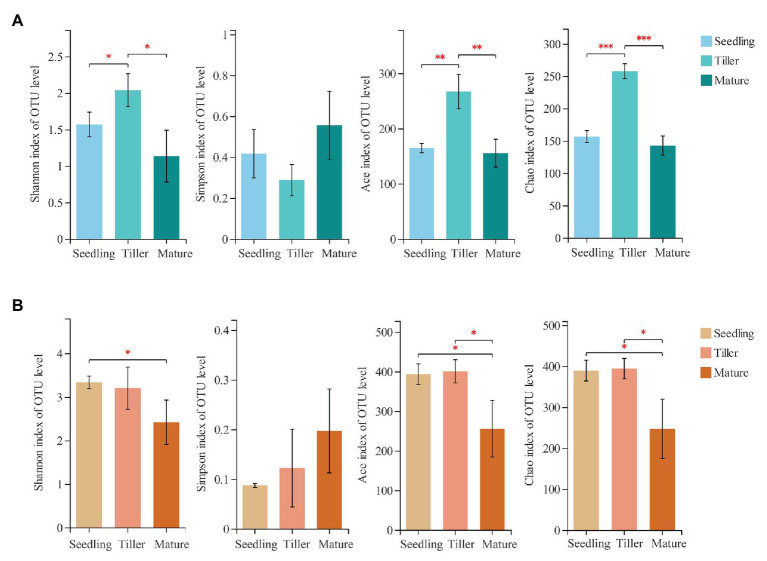
Estimated values of phyllosphere (A) and rhizosphere (B) fungal community relative abundances and diversity index. Asterisks indicate significant differences among plant development stages (Student’s t-test for estimator, *p < 0.05; **p < 0.01; ***p < 0.001).